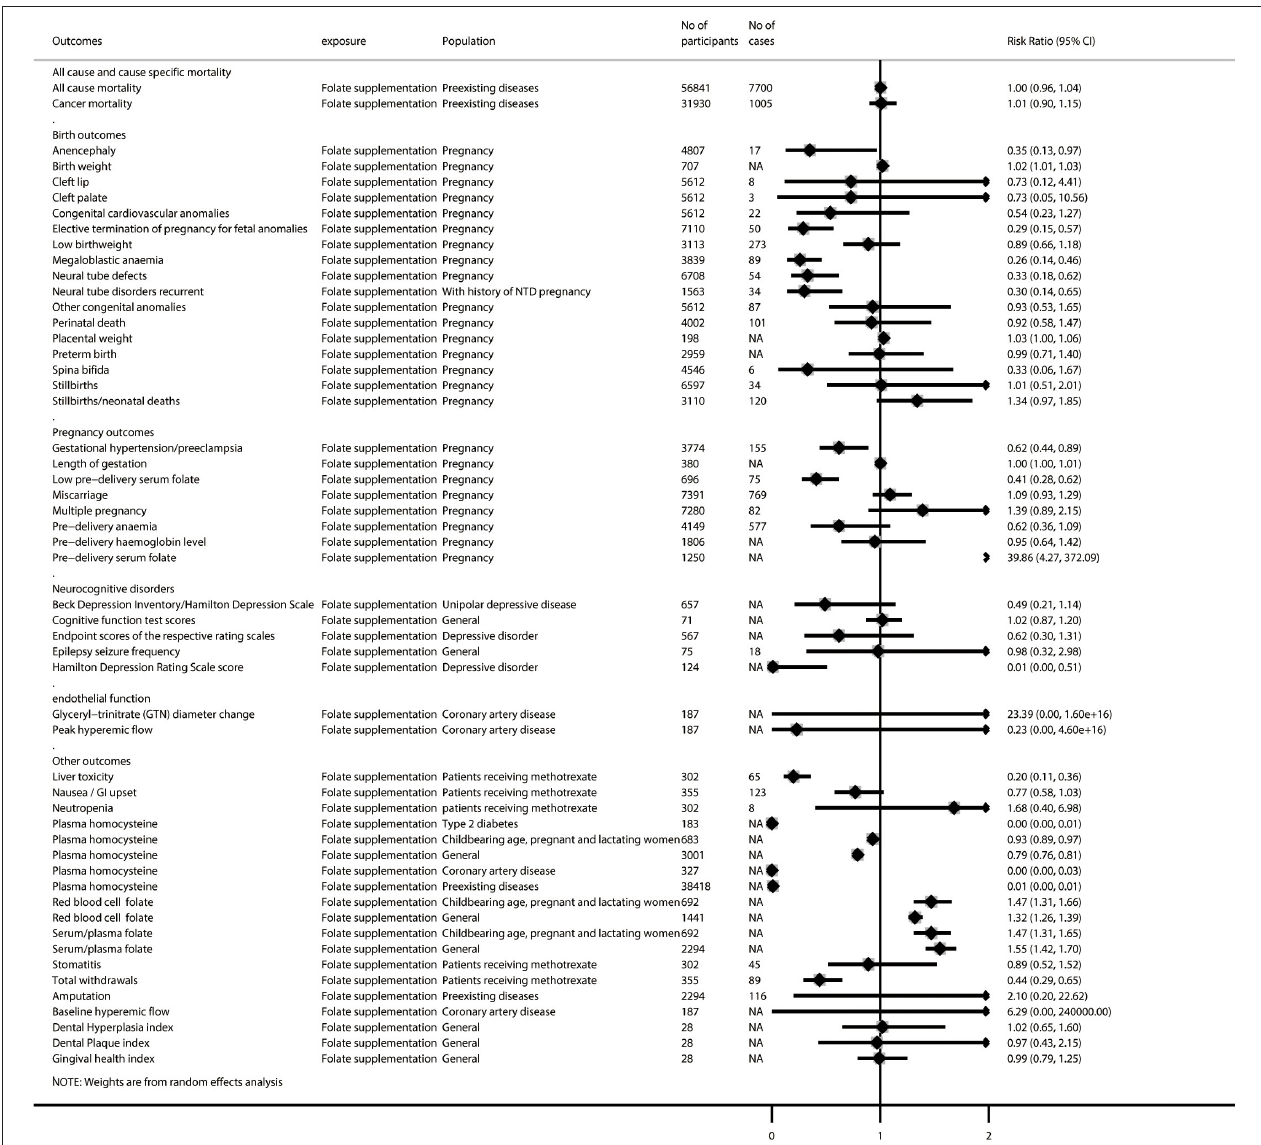
FIGURE 4 | Summary random-effects estimates of all-cause and cause-specific mortality, birth outcomes, pregnancy outcomes, neurocognitive disorders, endothelial function, and other outcomes reported in meta-analyses of randomized controlled trials.